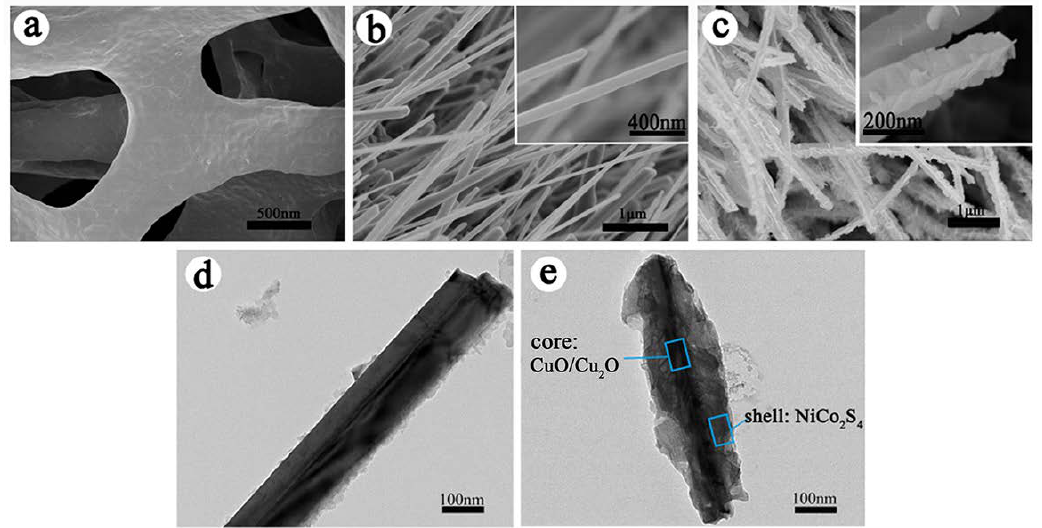
Figure 3. Scanning electron microscopy (SEM) images of ( a ) copper foam; ( b ) CuO/Cu 2 O nanowires and ( c ) CuO/Cu 2 O@NiCo 2 S 4 -4 composite nanowires (The insets in ( b ) and ( c ) show high-magnification of respective SEM images); transmission electron microscopy (TEM) images of ( d ) CuO/Cu 2 O nanowires and (e ) CuO/Cu 2 O@NiCo 2 S 4 -4 composite nanowires.